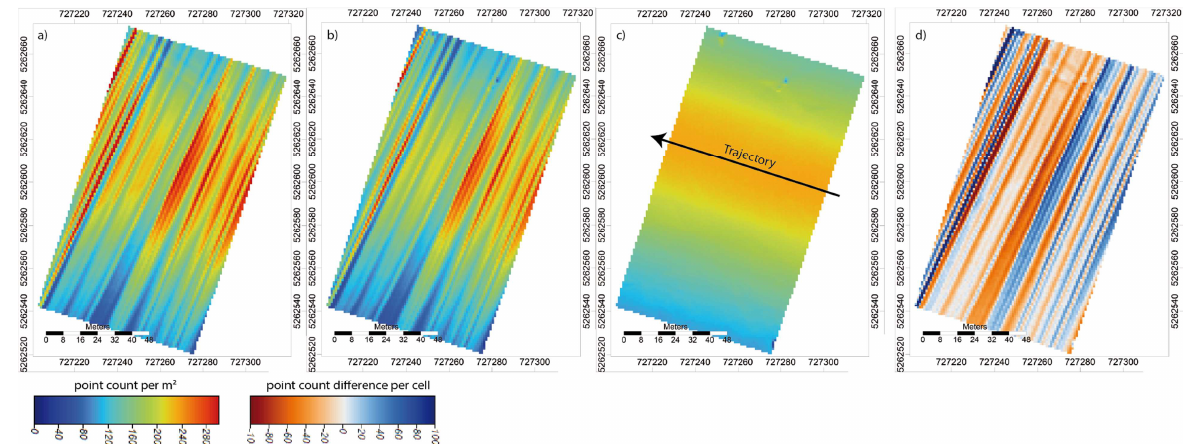
Figure 7. Laser point density and density difference maps of simple test case (model airfield): a) real point densities of the acquired point cloud; b) simulated point densities based on flown trajectory with known copter behaviour; c) simulated point densities based on planned trajectory; d) difference between real and simulated (planned) point